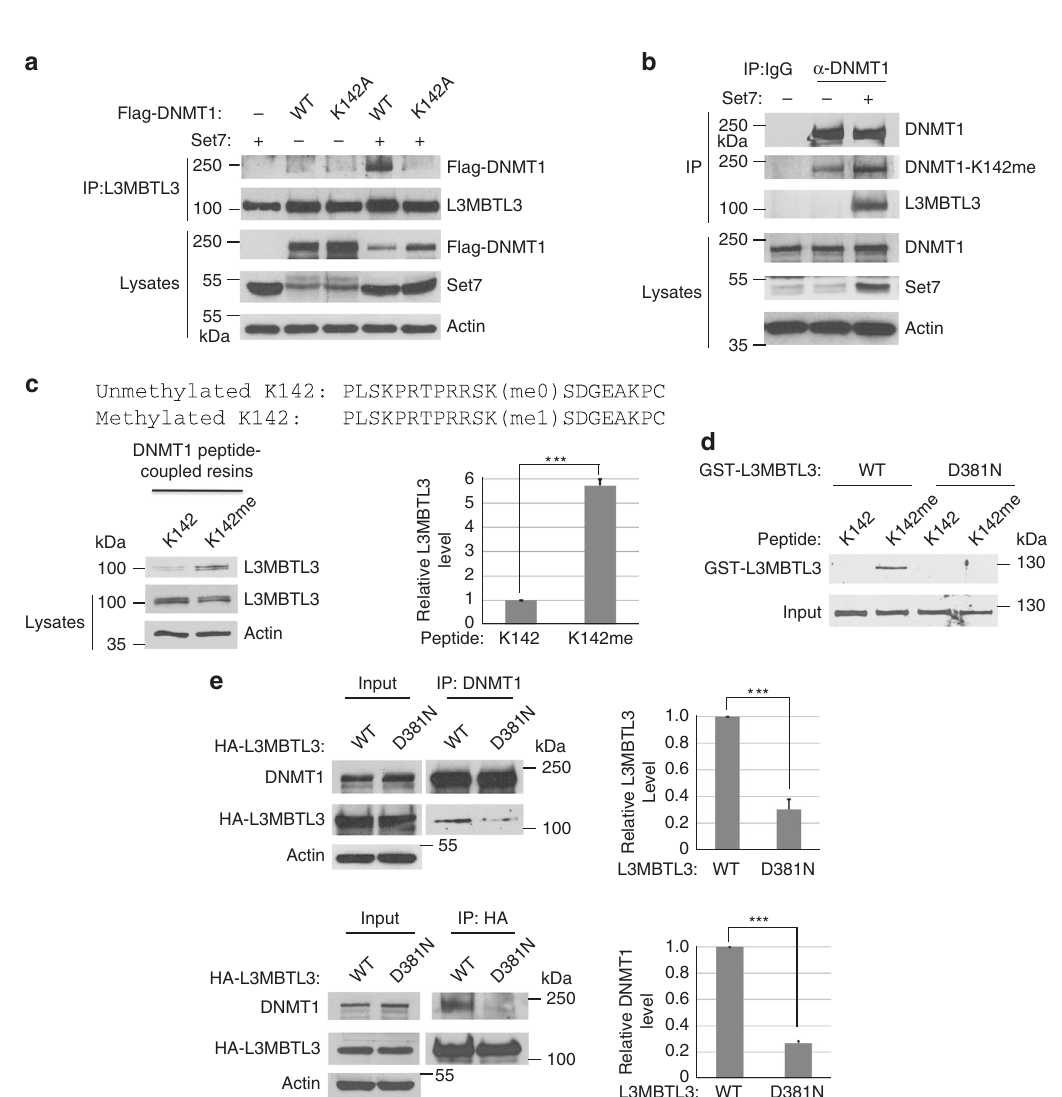
– 54 of its DNA methyltransferase activity 50 . We found that the methylation levels of the DNMT1 protein are higher in S phase cells arrested by aphidicolin, a DNA polymerase inhibitor, than that of asynchronously growing HCT116 cells (Fig. 8a), whereas DNMT1 in G1 cells, released from mitotic shake-off after treat- ment of microtubule inhibitor nocodazole 55 , has a lower content of K142 methylation (Fig. 8b). Since G1 cells usually take about